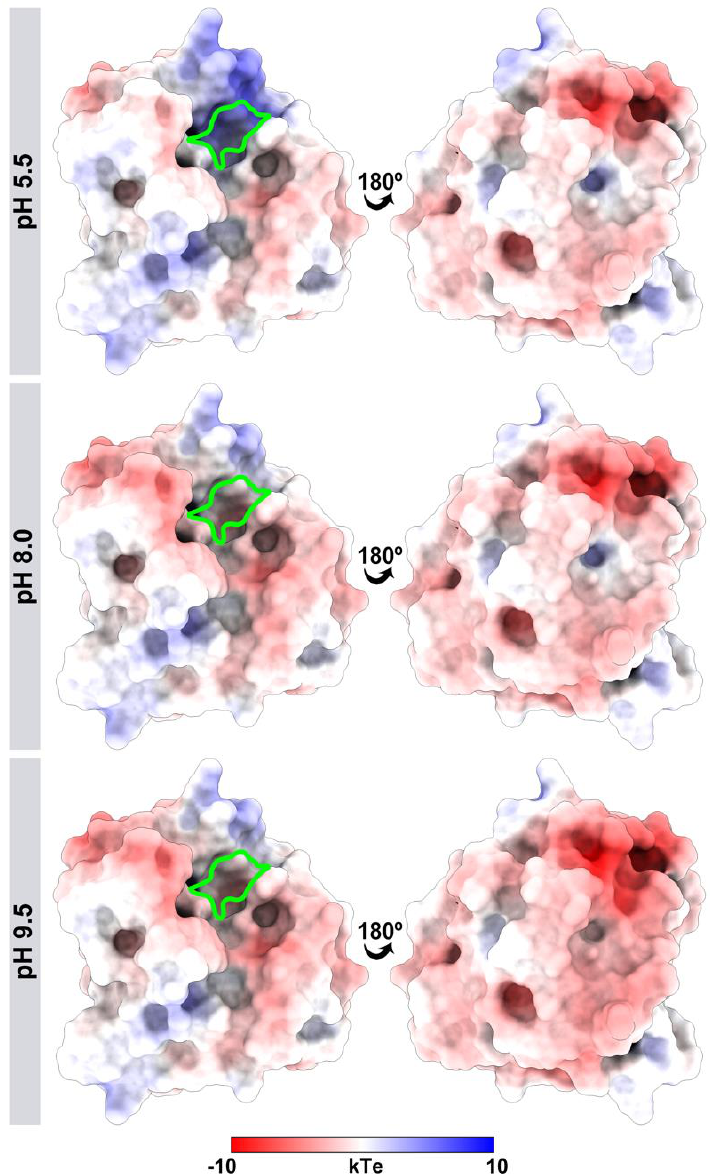
Figure 9. Differences in the electrostatic potential of J. curcas esterase B at different pH values (5.5, 8.0, and 9.5). The catalytic triad region (Cys-78, Asp-126, and His-161) is highlighted in green. The molecular surface is colored according to the electrostatic potential, where red, white, and blue correspond to acidic, neutral, and basic potentials.